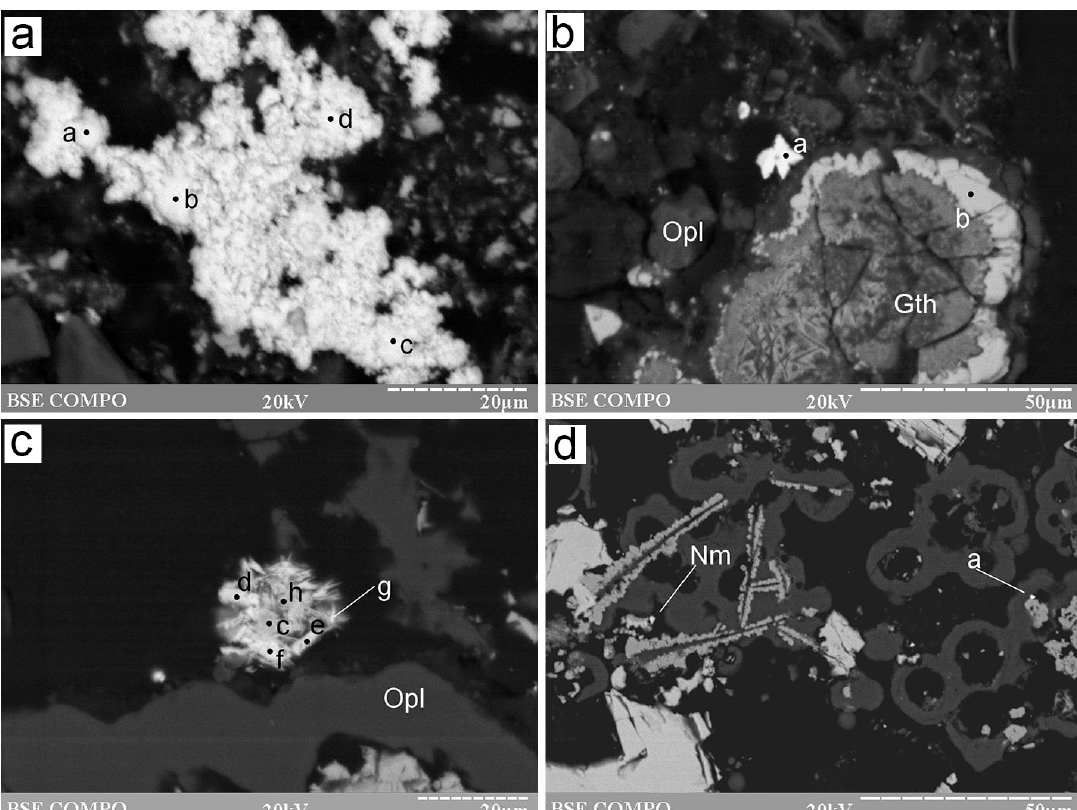
Figure 9. Morphology of Ag-rich sulfides and native gold from the Irinovskoe HSF: ( a ) Interstitial knobby aggregate of acanthite (points a–d); ( b ) Star-shaped crystalline acanthite aggregate (point a) on opal around sphalerite (point b); ( c ) Bladed Sb–Cu-bearing acanthite crystals (points d–g) with interstitial Ag–Sb-bearing covellite (points c and h); ( d ) Naumannite grain (Nm) on top of covellite (point d) and opal and inclusions of native gold (point a) at the boundary of sphalerite and opal. BSE images. Samples: 241-2/2-5 ( a , b ), 241 ( c ), 241-2/3-2 ( d ).